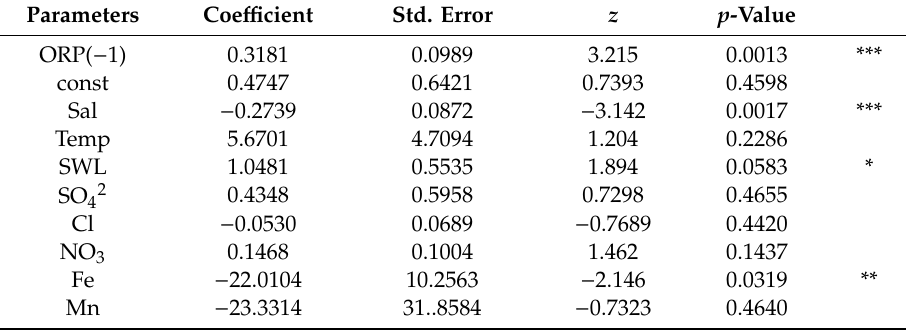
Table 4. Multiple regression statistical model with dependent variables against the Eh as independent variables for selected wet season hydrochemical